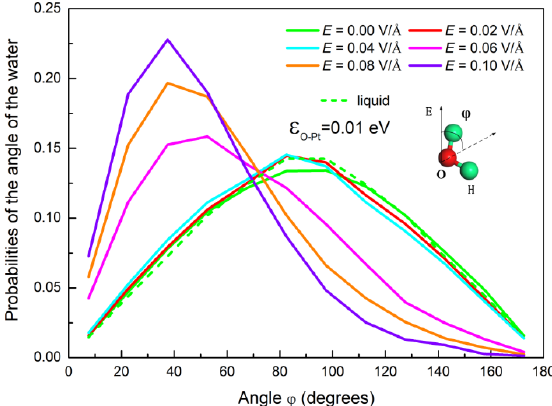
Figure 4. The probability distribution of the angle of the water molecules under different electric fields. The inset is a schematic for the angle φ .